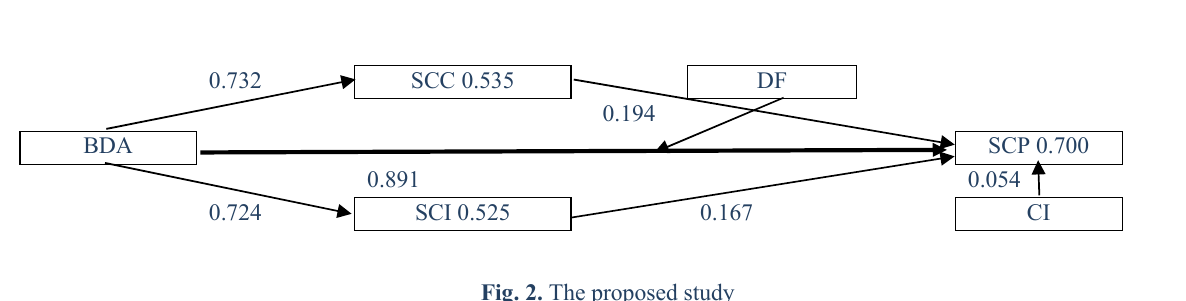
Fig. 2. The proposed